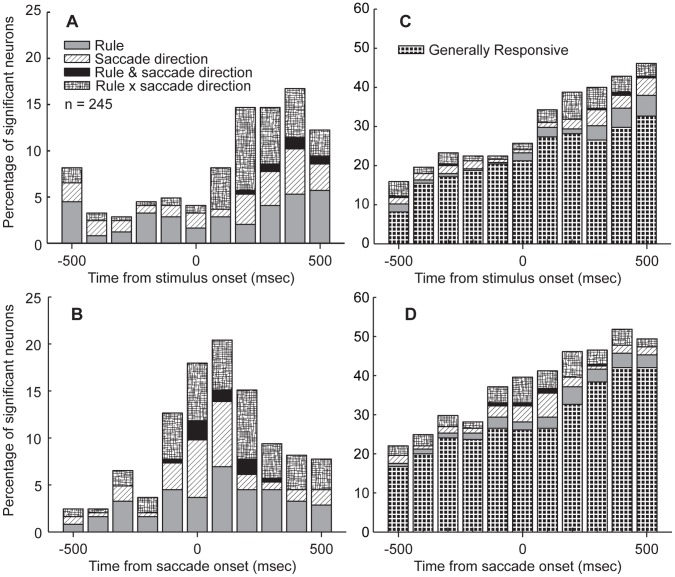
Time-course of ANOVA-identified percentage of task-modulated neurons.In order to explore the time-course of task-selectivity in the population of putamen neurons, we employed a two-way ANOVA with factors rule (pro, anti) and saccade direction (contraversive, ipsiversive) to examine putamen neuron activity in progressive 100-msec analysis bins around the peri-stimulus (A) and peri-saccade (B) period. The sharper and larger peak in the percentage of modulated neurons prompted us to use a peri-saccade analysis window for the remaining analyses of task-related modulations. C&D. We plotted the same time-courses of population selectivity again, but included the percentage of “generally responsive” neurons, which are characterized as having analysis epoch activity that is significantly different from zero when baseline values are subtracted (C shows peri-stimulus time-course and D shows the peri-saccade time-course).